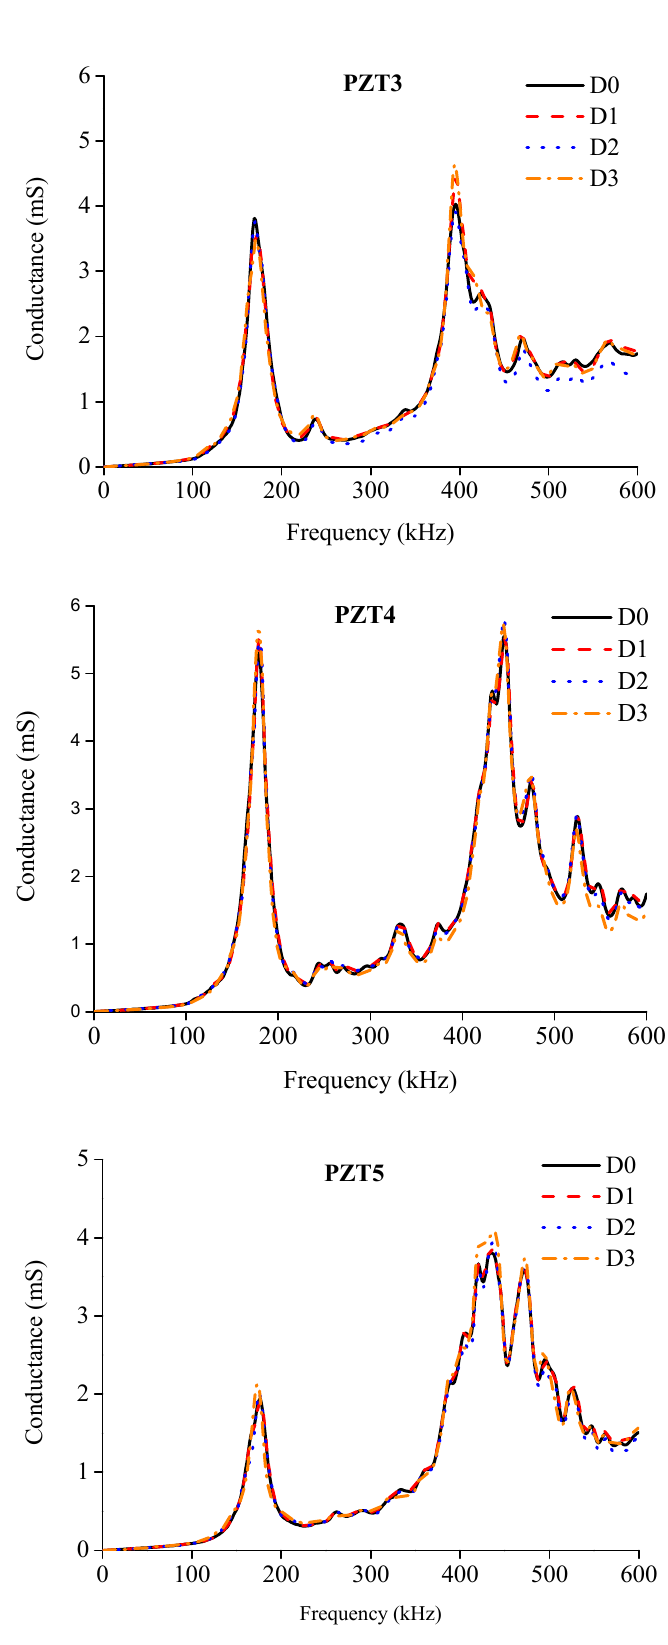
Figure 9. Comparisons of electrical conductance signature of each PZT sensor under different damage levels of BE1.